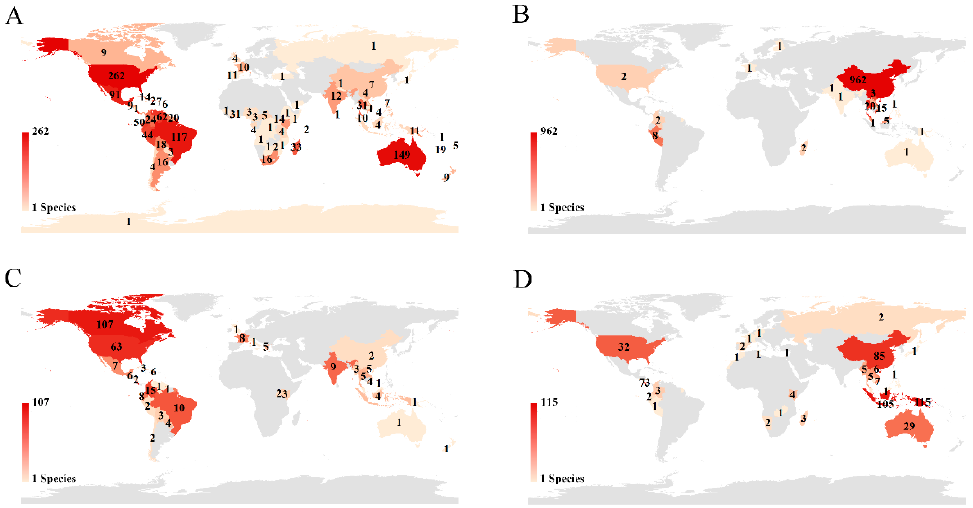
Figure 7. The distribution maps of holotypes of new species published by authors from the top four countries. ( A ) USA. ( B ) China. ( C ) Canada. ( D ) Germany. The degree of the red color represents the different amounts of new species described.